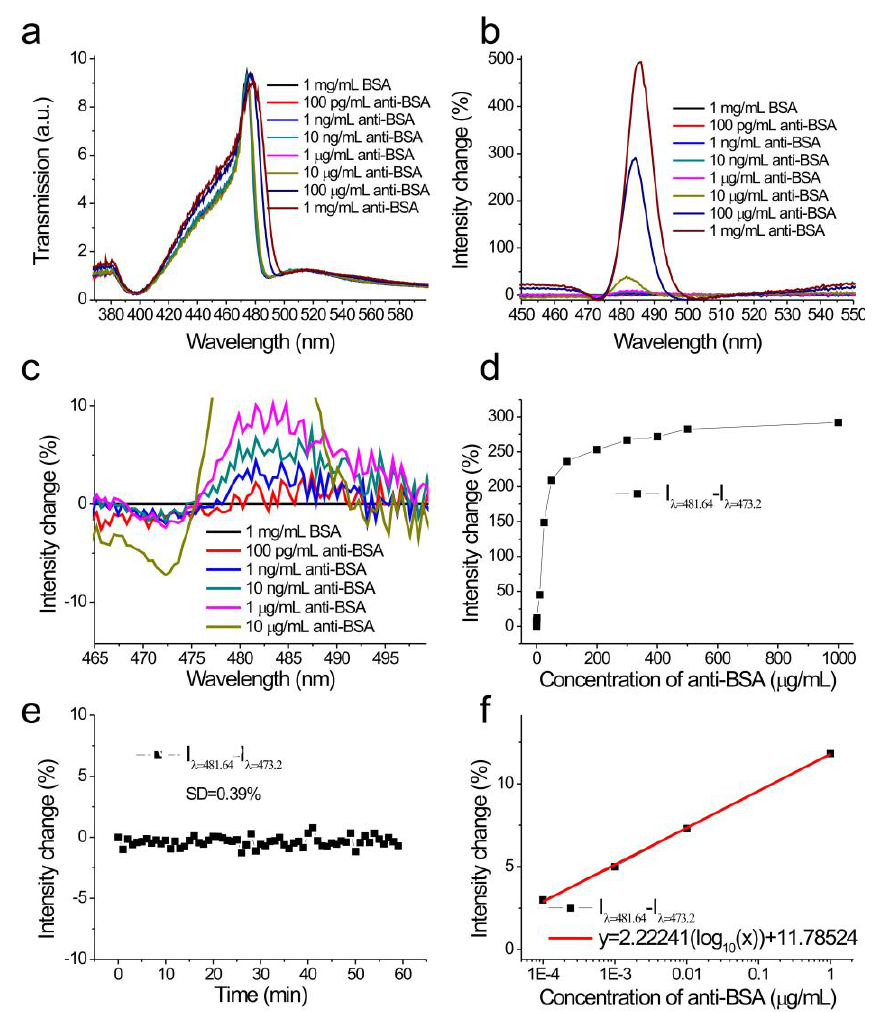
Figure 5. ( a ) The measured transmission spectra in 1 mg/mL bovine serum albumin (BSA) and different concentrations of anti-BSA solutions from 100 pg/mL to 1 mg/mL; ( b ) the spectral intensity changes caused by different concentrations of anti-BSA solutions. The transmission spectrum of the BSA solution was set as a reference; ( c ) the enlarged spectral intensity changes caused by different concentrations of anti-BSA solutions; ( d ) the intensity change difference (I diff = ∆ I/I λ = 481.64 − ∆ I/I λ = 473.20 ) as a function of the concentration of anti-BSA; ( e ) the intensity change as a function of the logarithm of the concentration of the anti-BSA solution; ( f ) the intensity change (I λ = 481 − I λ = 473 ) as a function of time.